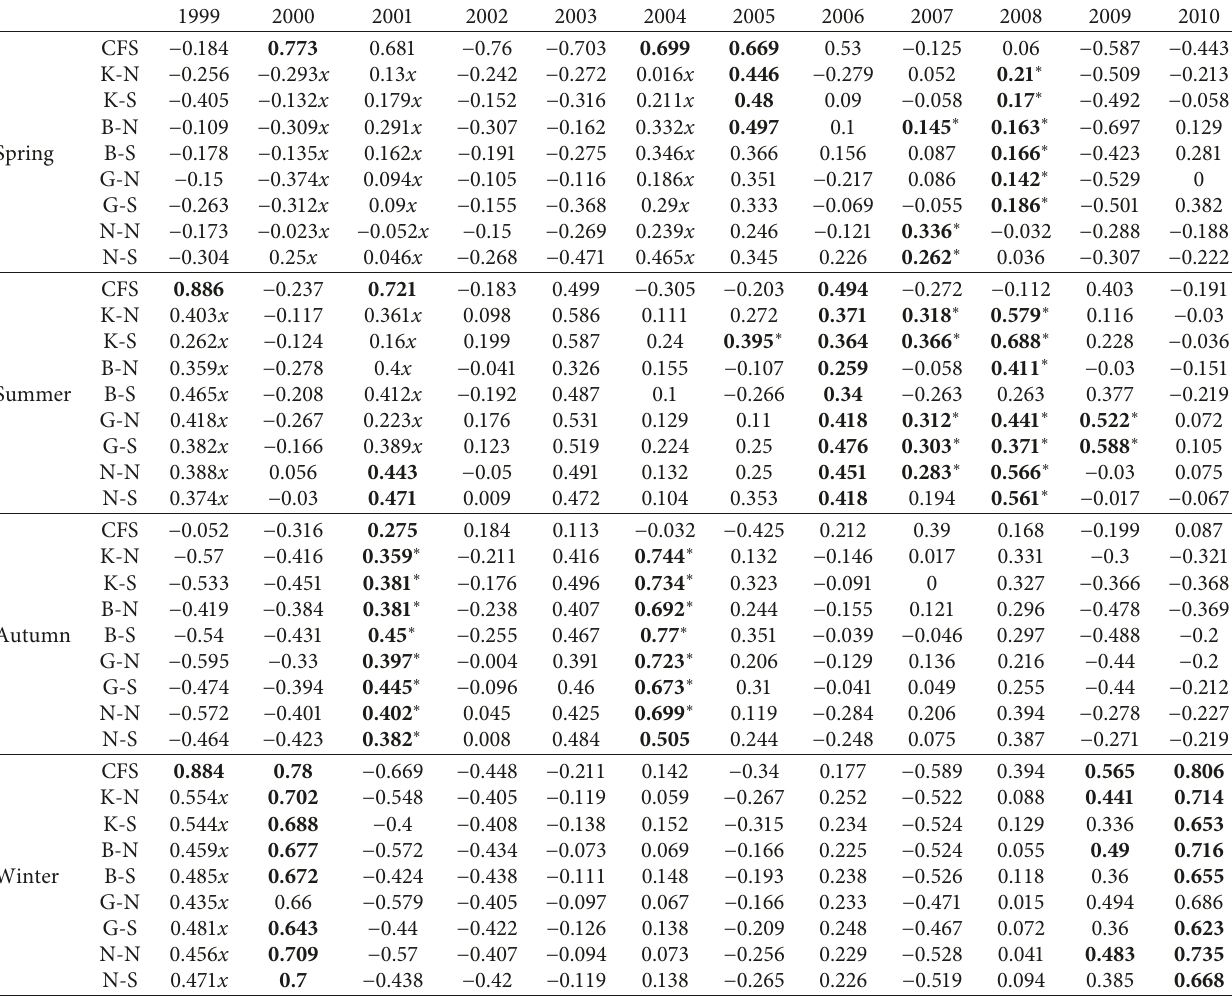
Table 3: Anomaly correlation coefficients of seasonal precipitation forecasts from 1999 to